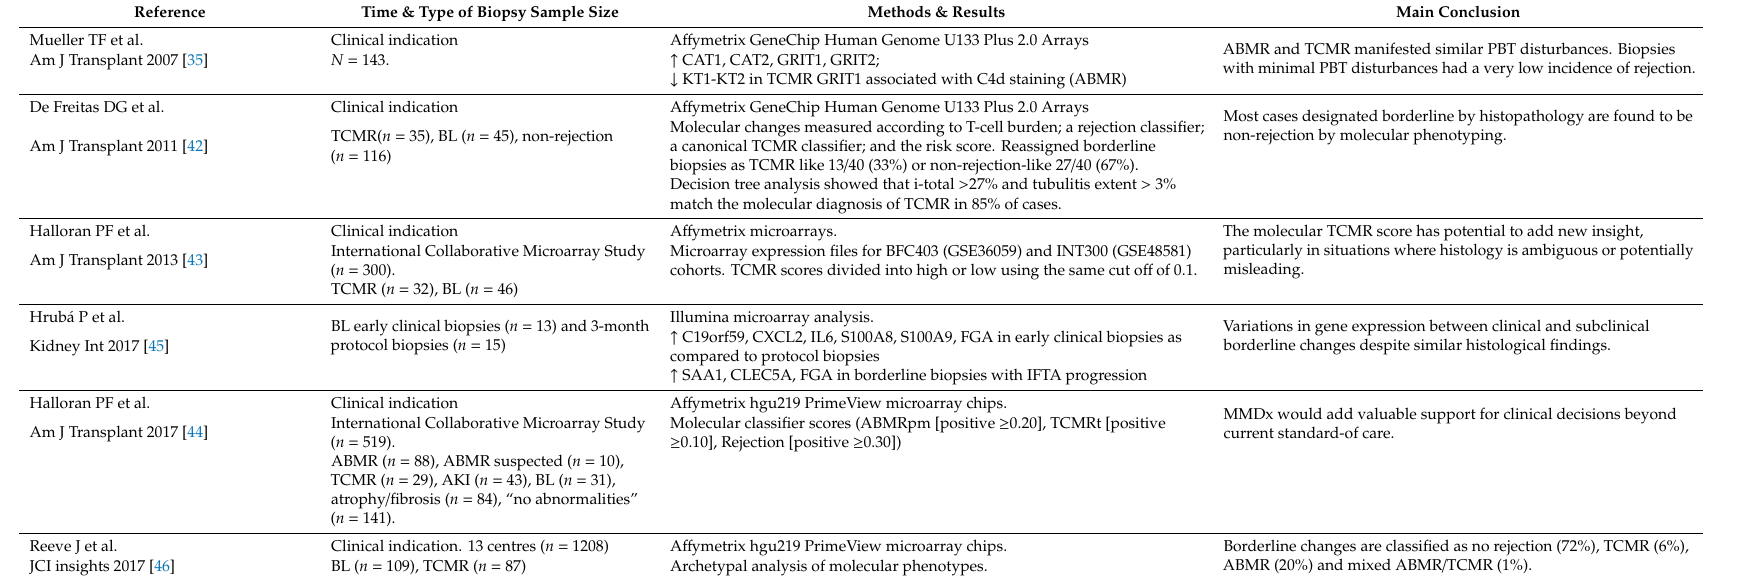
Table 1. Transcriptome analysis on indication biopsies with borderline changes-histological category and di ff erent controls. ABMR, antibody-mediated rejection; TCMR, T-cell mediated rejection; BL, borderline changes; PBTs, pathogenesis-based transcripts; CATs, infiltration of cytotoxic T cells; GRIT1, interferon-gamma